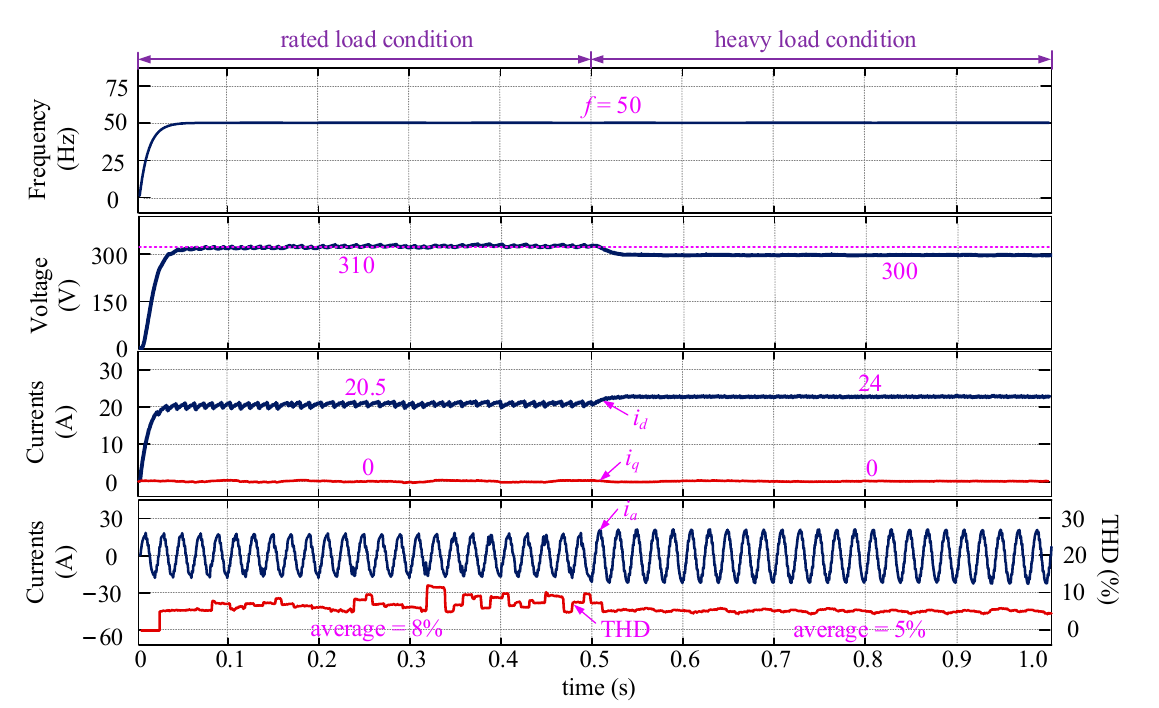
Figure 8. Control performance of the proposed DCL method without parameter mismatch and EV uncertainties considered.